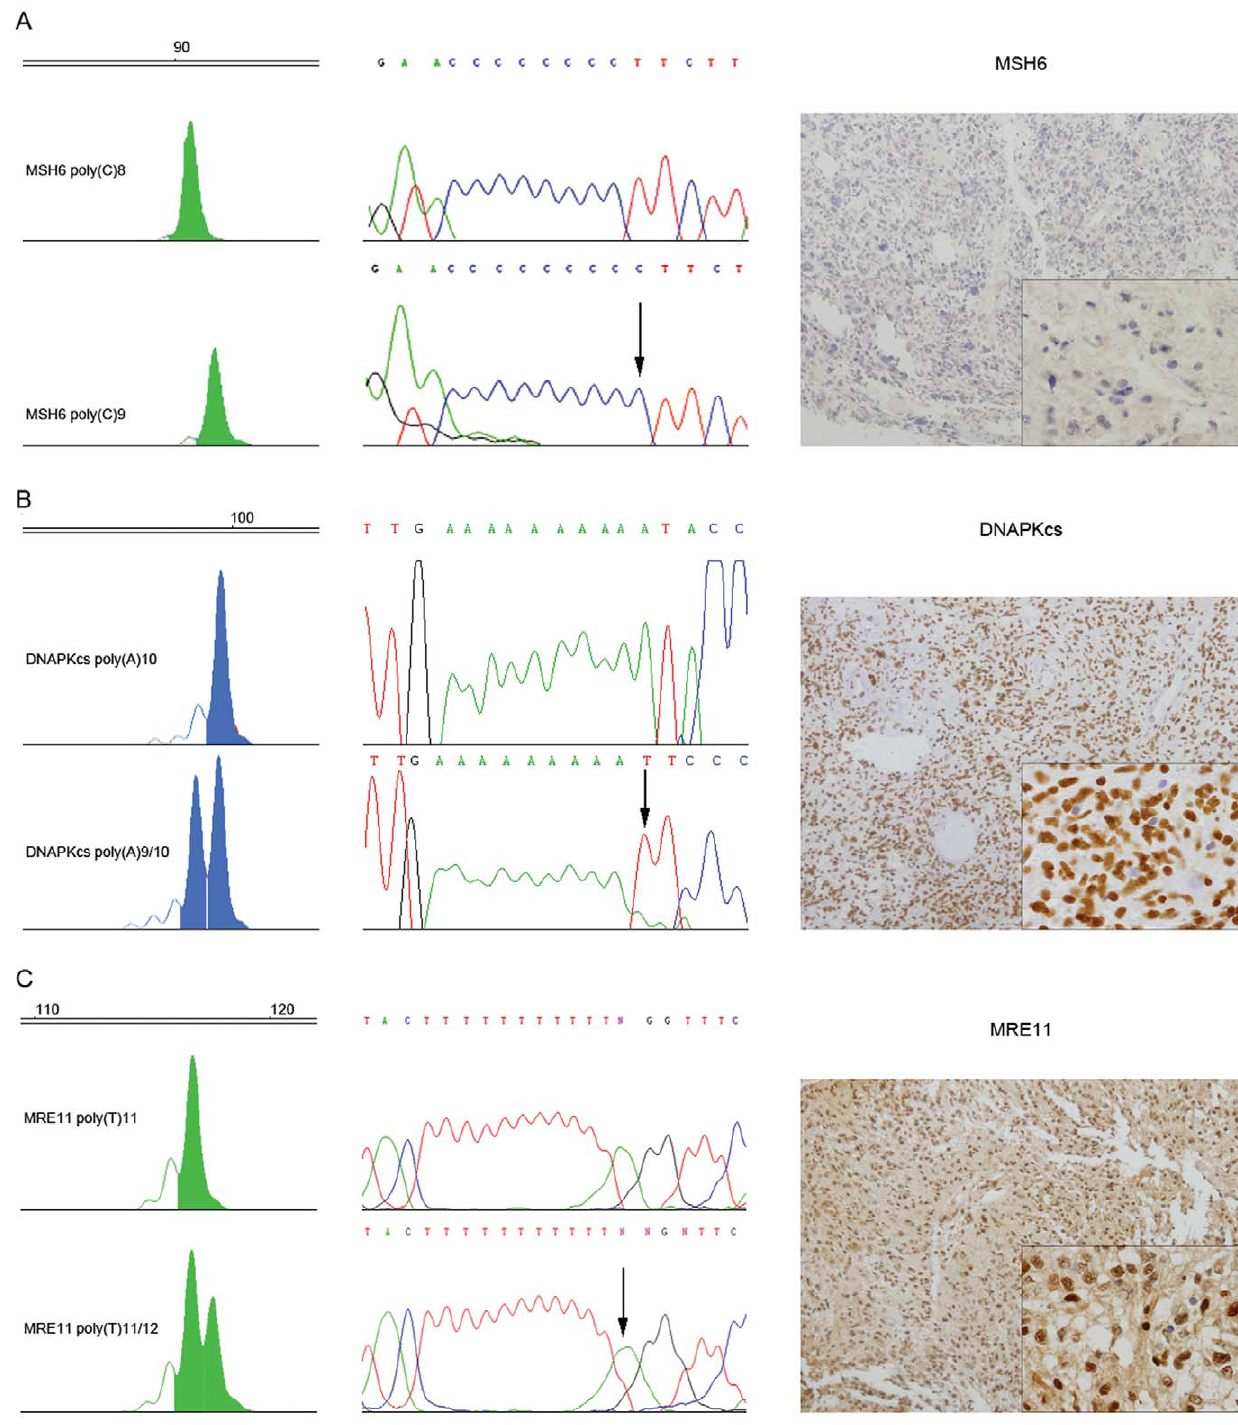
Figure 3. Target gene screening in MSI pediatric HGG. Electropherogram traces, direct sequencing, and immunohistochemistry for MSI target genes presenting frameshift mutations in pediatric HGG (DNA alterations indicated with arrows). (A) Case RMH2452 (MSI-H) presenting a homozygous insertion of one bp in the MSH6 poly(C)8 tract and loss of protein expression. (B) RMH3969 (MSI-L) presenting a heterozygous deletion of one bp in the DNAPKcs poly(A)10 tract, and retention of protein expression. (C) RMH2444 (MSI-L) presenting a heterozygous insertion of one bp in the MRE11 poly(T)11 tract and retention of protein expression.